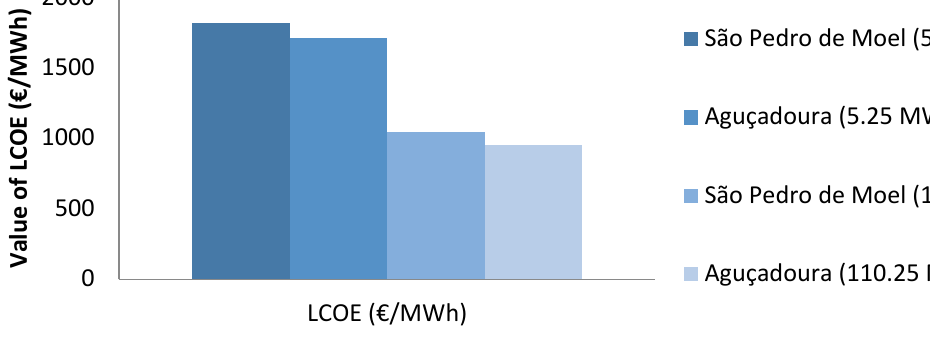
Figure 10. LCOE of several wave farms.